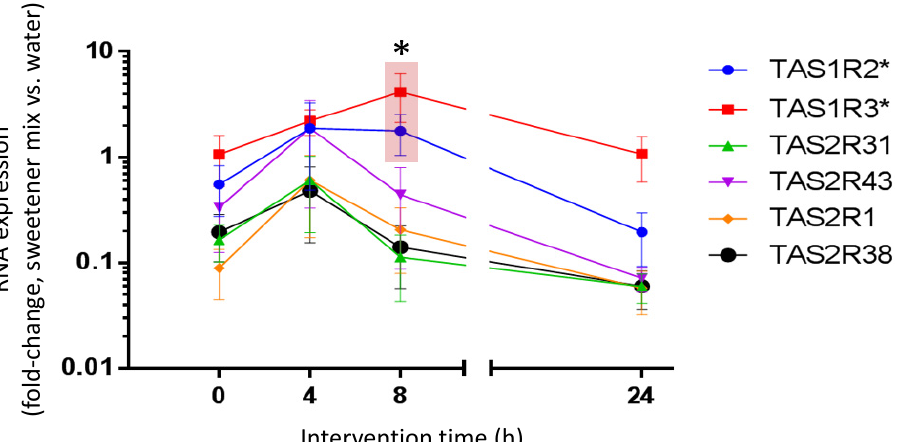
Figure 5. Taste receptor transcript level kinetics during beverage-typical sweetener mix intervention. The RNA was isolated from primary neutrophils of study participants ( n = 10) before ingestion (0 h) of a food-typical mix of acesulfame-K, cyclamate, and saccharin, as well as 4, 8, and 24 h after ingestion. This was contrasted with matched measurements derived from participants ingesting only water (control). Gene expression was determined by RT-qPCR, compared to the mean expression of three housekeeper genes (2 − ∆ Cq ), and displayed as fold-change between water control and mix. * TAS1R2 and TAS1R3 expression were significant at 8 h (Wilcoxon sign-rank test; TAS1R2: 8 h vs. 24 h, p = 0.0059; TAS1R3: 8 h vs. 0 h, p = 0.0195). Data are mean ±